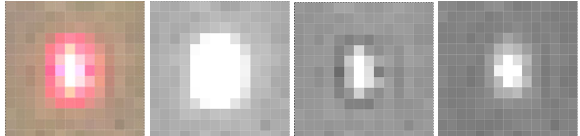
Figure 14. Laser spot on image of the PCO camera; from left to right: RGB image, red, green and blue colour channel